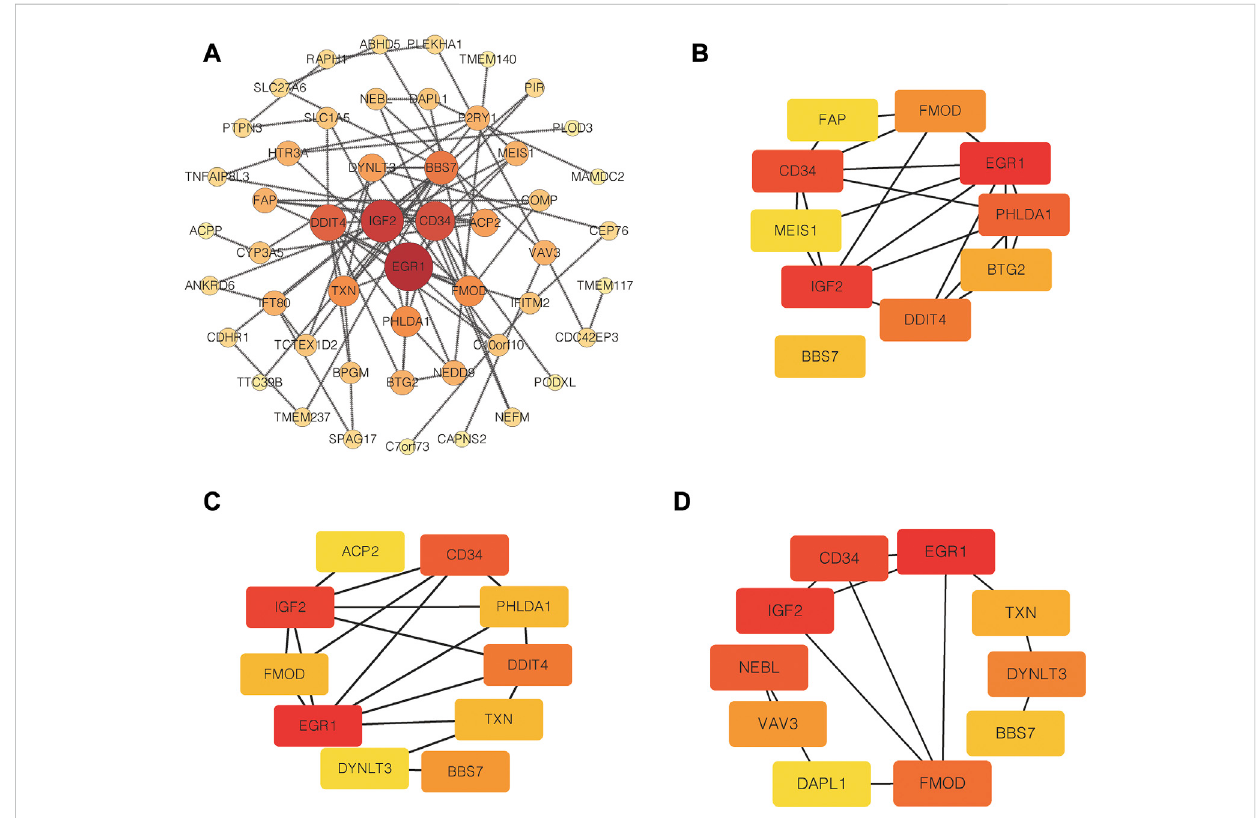
FIGURE 5 PPInetworkconstructionandhubgenesselection. (A) PPInetworkofcommonDEGs. (B) Top10highlyconnectedgenesbasedonMCCalgorithms. (C) Top 10 highly connected genes based on degree algorithms. (D) Top 10 highly connected genes based on Stress